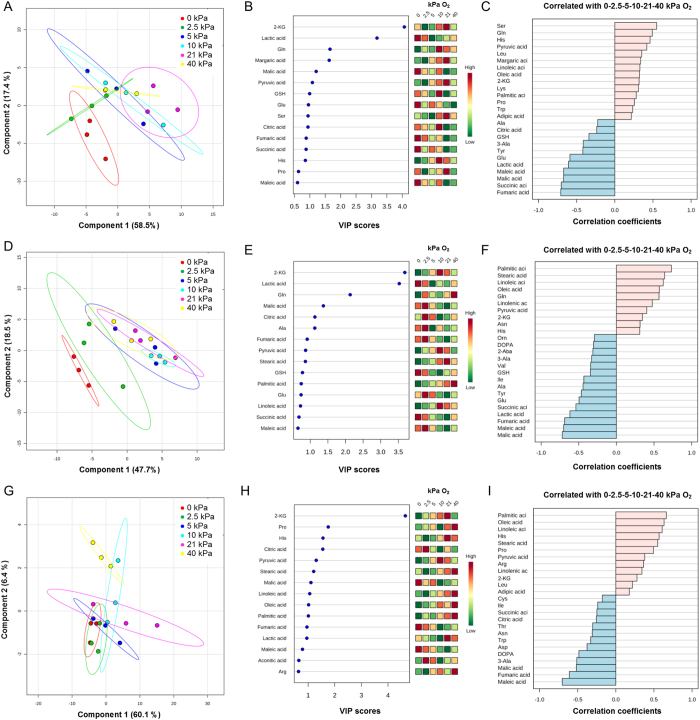
Results of metabolic profiling at each of the three timepoints sampled: before- (top row), during- (middle row) and after (bottom row) chill coma.2D score plots (A,D,G) showing the projection of samples onto the first discriminant plane for each of the three timepoints. Each point is a sample (four individuals pooled), colours represent different oxygen treatments (red: 0 kPa O2, green: 2.5 kPa O2, blue: 5 kPa O2, turquoise: 10 kPa O2, pink: 21 kPa O2, yellow: 40 kPa O2) and lines indicate 95% confidence intervals. The variable importance plots (B,E,H), based on VIP scores, shows the top 15 variables that contribute to component 1 at each of the timepoints (based on Pearson correlation). The coloured boxes on the right indicate the relative concentrations of each of the metabolites in each oxygen treatment, with reds indicating highest concentrations and greens the lowest concentrations. Pattern finding analysis (C,F,I) at each timepoint sampled shows the top 25 metabolites that correlated with the increase in oxygen treatments (i.e. from 0 to 40 kPa O2). Metabolites in red are positively correlated with the increase in oxygen (i.e. highest concentrations at highest oxygen), while those in blue were negatively correlated (i.e. highest concentrations at lowest oxygen). Note that these results do not necessarily denote significance. Significant differences between oxygen treatments within each timepoint can be found in Table S3. Refer to Table S2 for compound abbreviations.